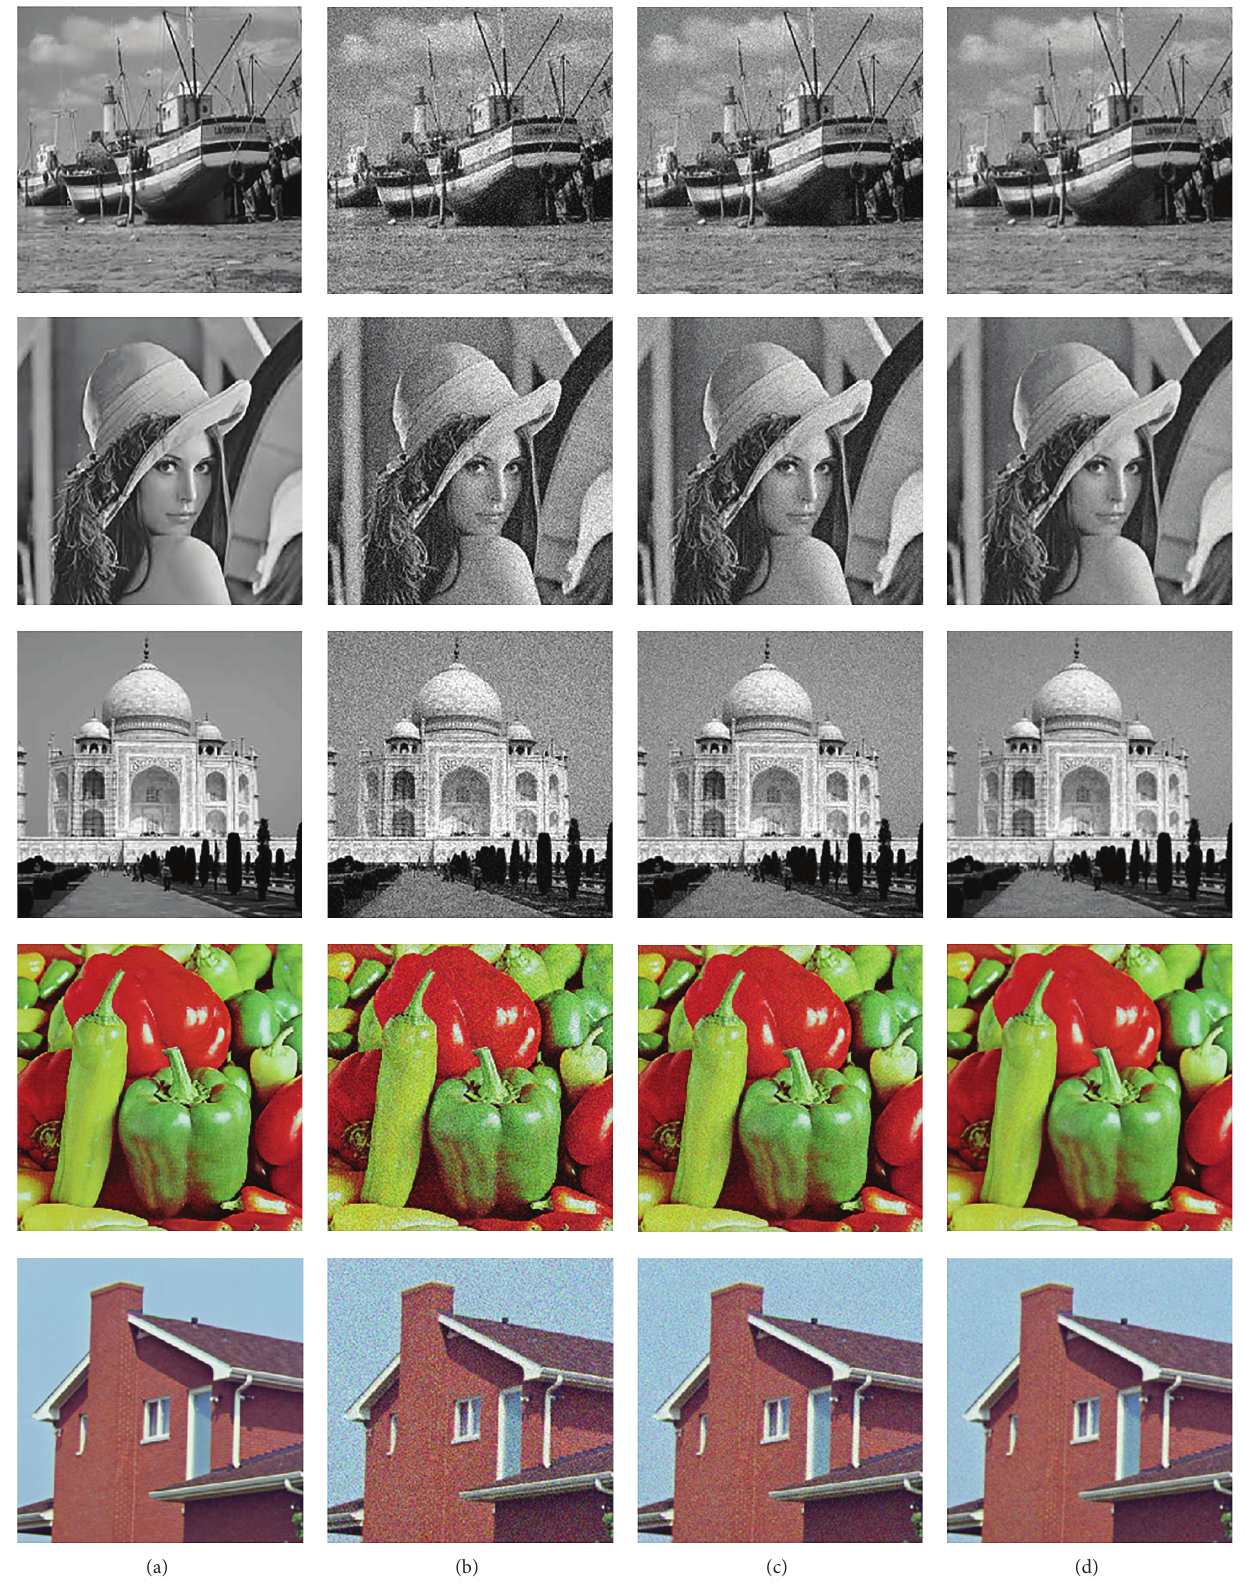
Figure 5: Denoising results, (a) original image, (b) corrupted image with Gaussian noise with 𝜎 value of 15, (c) Gaussian smoothing filter, and (d) FHD